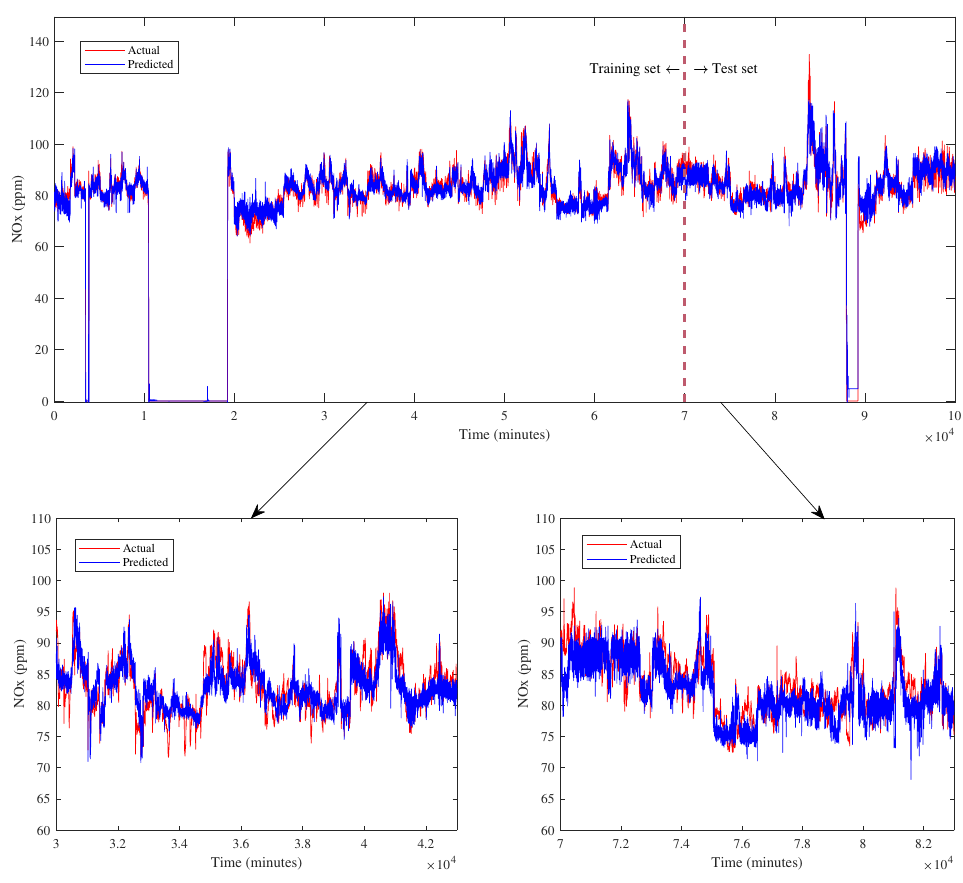
Figure 11. NO x prediction from the proposed